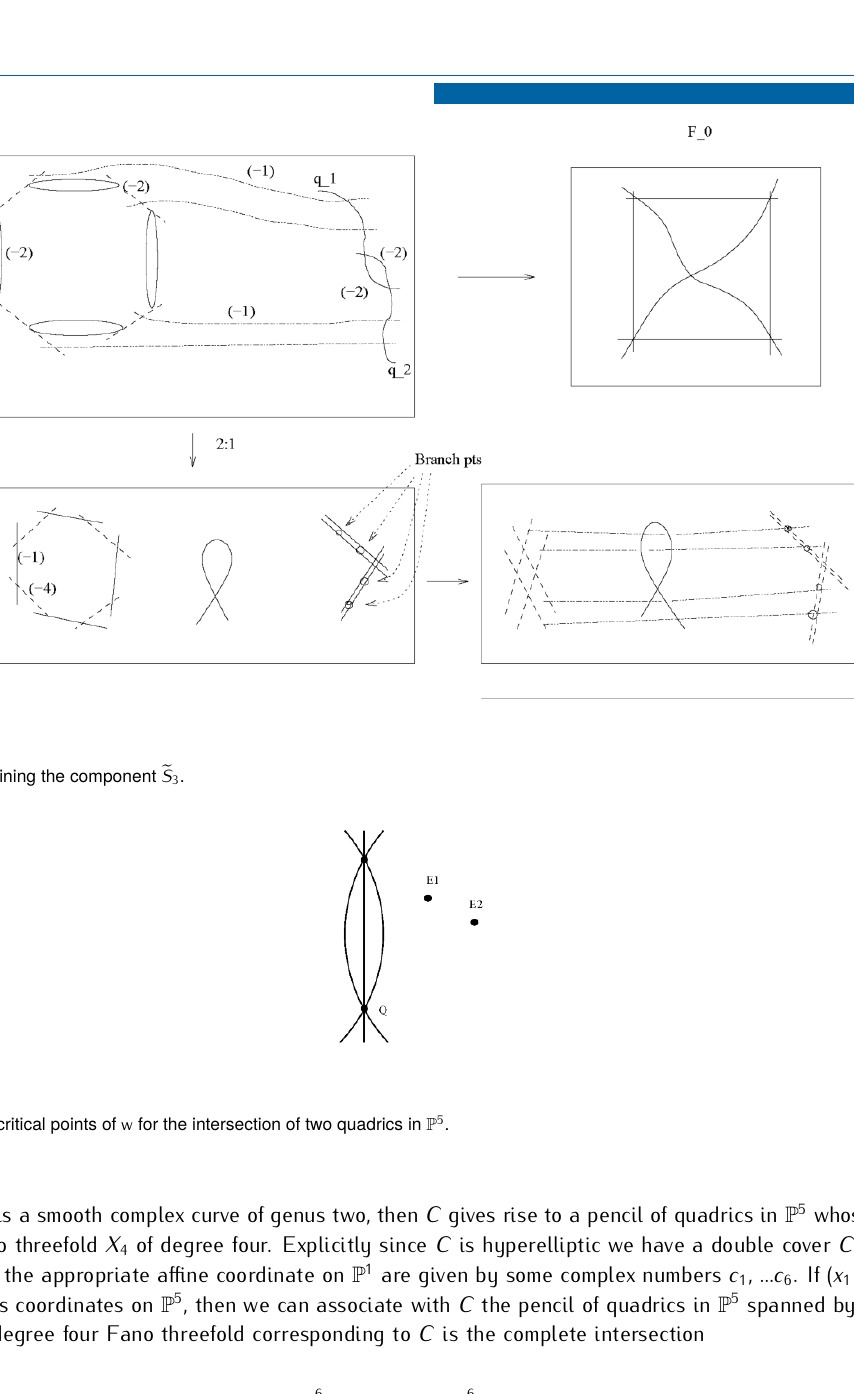
w for the intersection of two quadrics in